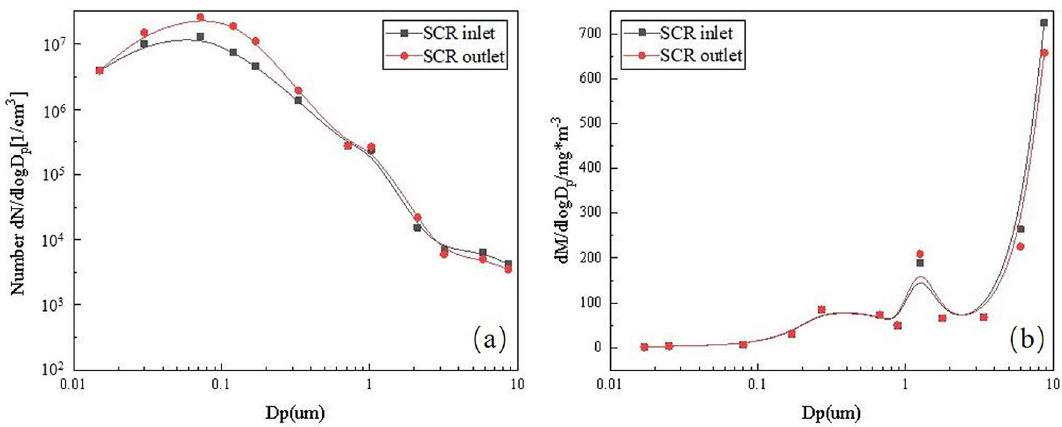
Figure 7. Changing in particulate matter at inlet and outlet of SCR reactor 12 ( a : Number concentration, b : Mass